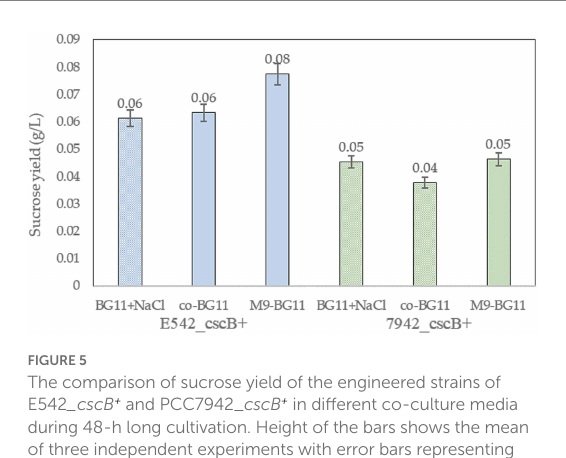
FIGURE 5 The comparison of sucrose yield of the engineered strains of E542 _cscB + and PCC7942_ cscB + in different co-culture media during 48-h long cultivation. Height of the bars shows the mean of three independent experiments with error bars representing SD from